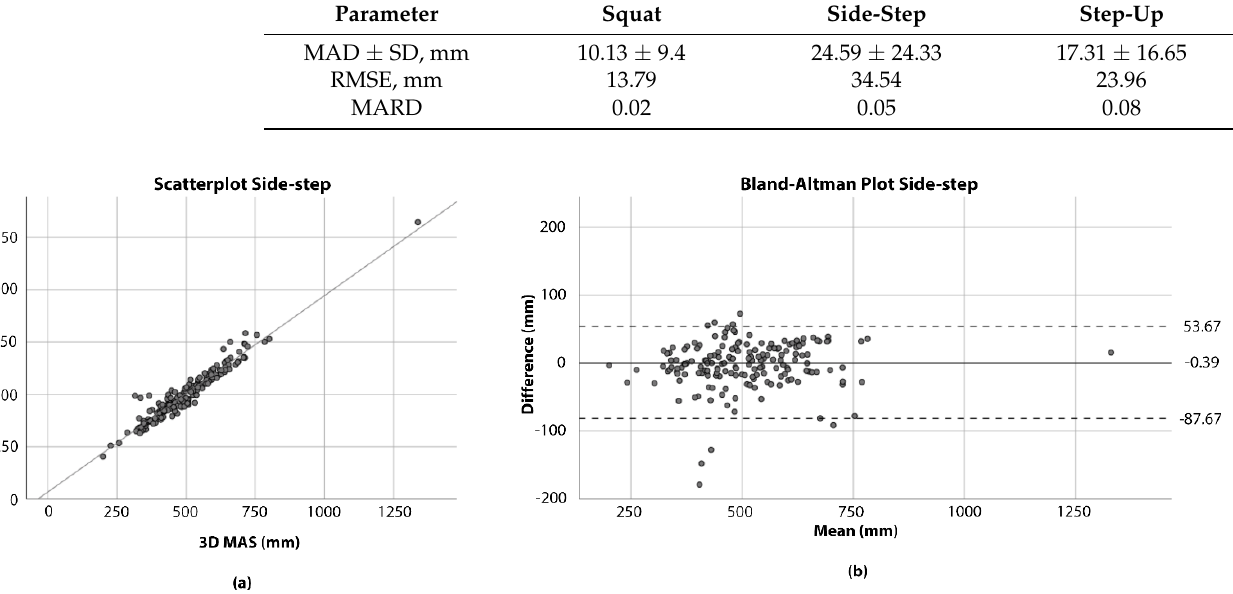
Figure 5. Scatterplots and Bland-Altman plots for the examined exercises. In the Bland-Altman plots the dotted lines rep- resent the limits of agreement and the bold line the median. ( a ) Shows the scatter plot for the side-step. ( b ) Shows the Bland-Altman plots for the side-step. ( c ) Shows the scatter plot for the squat. ( d ) Shows the Bland-Altman plots for the squat. ( e ) Shows the scatter plot for the step-up. ( f ) Shows the Bland-Altman plots for the step-up. 4. Discussion A mean difference of 0.47° to 0.73° could be identified for the rotational trajectories. In comparison, investigations of the performance of an Oculus Rift-based application for meas- uring the range of motion of the cervical spine revealed larger differences of 2.3° for the flexion angle, 5.4° for the lateral flexion angle and 3.7° for the rotation angle [40]. When comparing these measurement differences, it should be considered that, while executing the exercises correctly during the TG, the head is held relatively still in a constant line of vision.